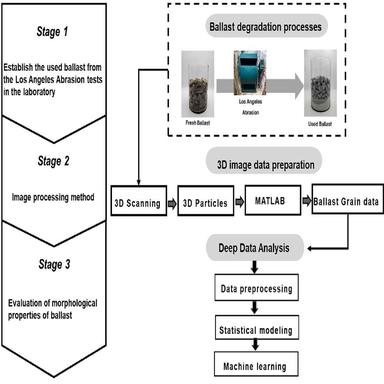
Flow diagram of the methodology.